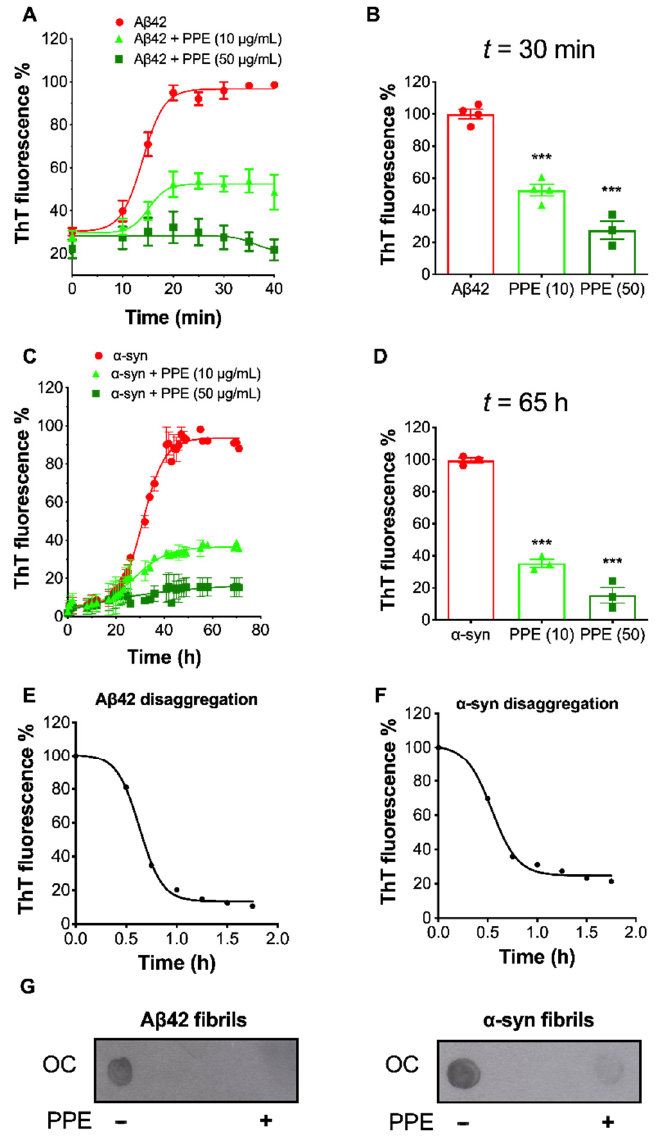
Figure 5. Effects of Padina pavonica extract on fibrillogenesis of A β 42 and α -syn. ( A , C ) Aggregation kinetics of 22.5 µ M A β 42 and 25 µ M α -syn were monitored using Thioflavin T, with and without PPE (10 or 50 µ g/mL) in phosphate buffer saline (PBS) buffer. Aggregations were performed at 37 ◦ C with agitation at 450 rpm. ThT fluorescence readings were measured in triplicate, and the means ± SD are shown at each data point, calculated as a percentage of the maximal ThT fluorescence intensities of the control peptide/protein aggregated alone ( n = 3). The kinetic data was fitted to a sigmoidal curve using GraphPad Prism. ( B , D ) Bar diagram showing maximal ThT signals achieved in the plateau phase of aggregation (at t = 30 min for A β 42 and t = 65 h for α -syn), in the absence and presence of PPE (10 or 50 µ g/mL) as a percentage of control peptide/protein aggregated alone. Values are expressed as means ± SD ( n = 3); *** p < 0.001 (one-way ANOVA). Refer to Suppl. Table S1 for F -values and p -values of one-way ANOVA. ( E , F ) Disaggregation properties of PPE are illustrated by time-dependent ThT fluorescence profiles following addition of PPE (10 µ g/mL) to completely aggregated A β 42 or α -syn (regarded as 100%). Data points represent the means ± SD of three replicate experiments ( n = 3) expressed as percentages of the control. ( G ) Dot blots were probed with Fibril OC antibody to detect A β 42 ( left panel ) and α -syn ( right panel ) fibrils, prepared in the absence ( − ) or after the addition of PPE (10 µ g/mL) for 2 h (+). A fainter spot indicates that amyloid fibrils were significantly reduced by